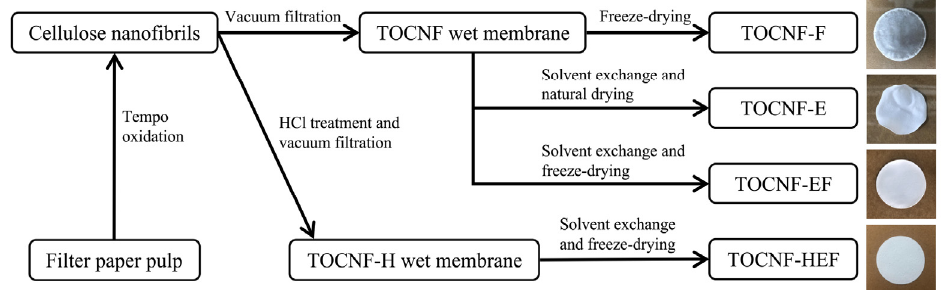
Figure 1. Flow chart illustrating the preparation process of TOCNF separators through freeze-drying, solvent exchange, freeze-drying after solvent exchanging, and acid-treated followed by freeze-drying after solvent exchanging.